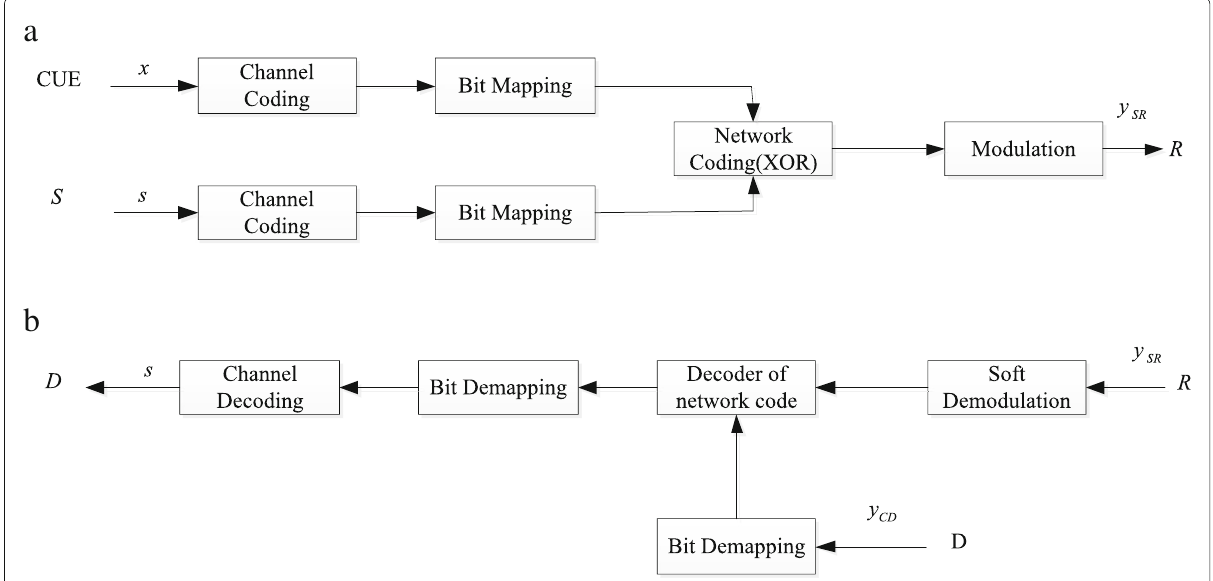
where P C and P C are the transmit power of the DUEs and the CUE respectively. h sr , h cr , and h cd are the channel gains between the users; n SR and n DD are additive white Gaussian